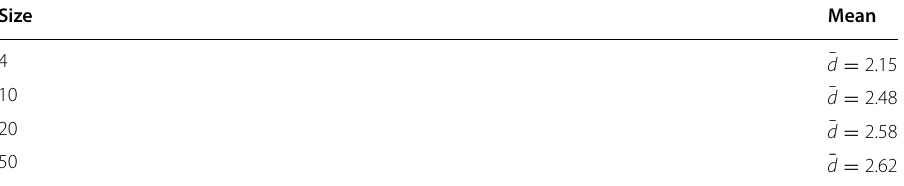
Observed mean degree from simulation study for networks with target degree of d = 2 by network size